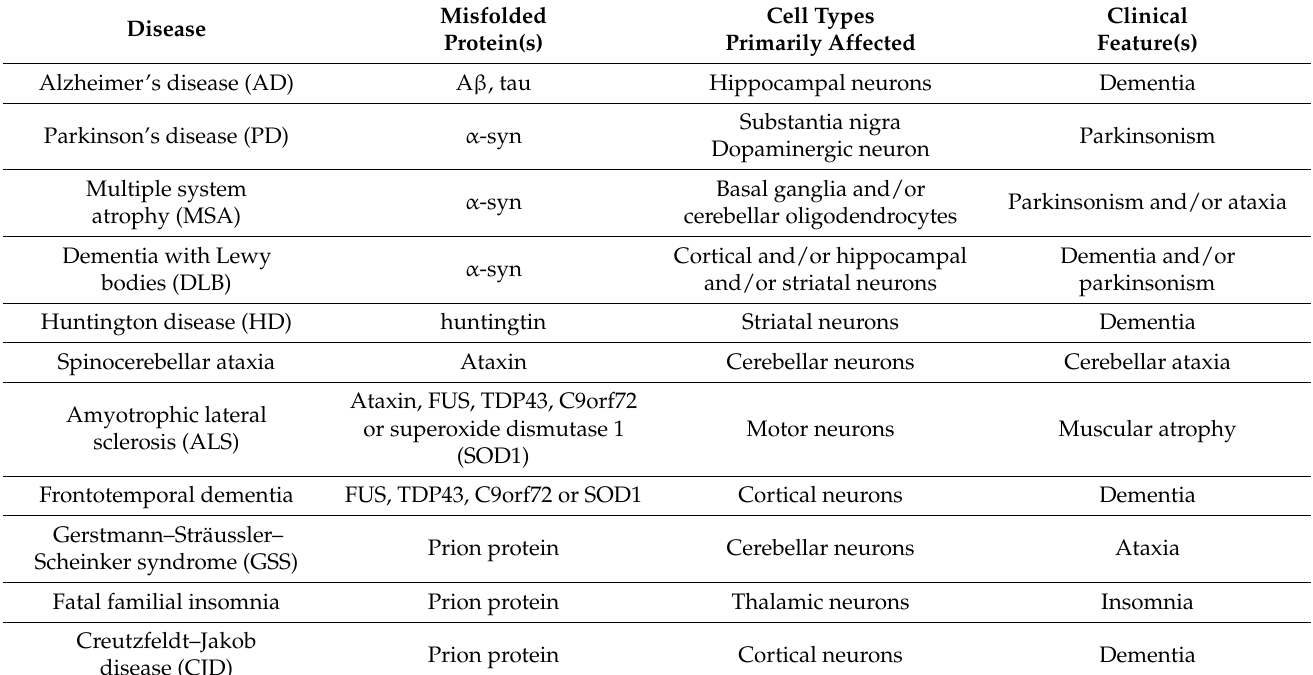
Table 1. Protein misfolding disorders affecting the nervous system